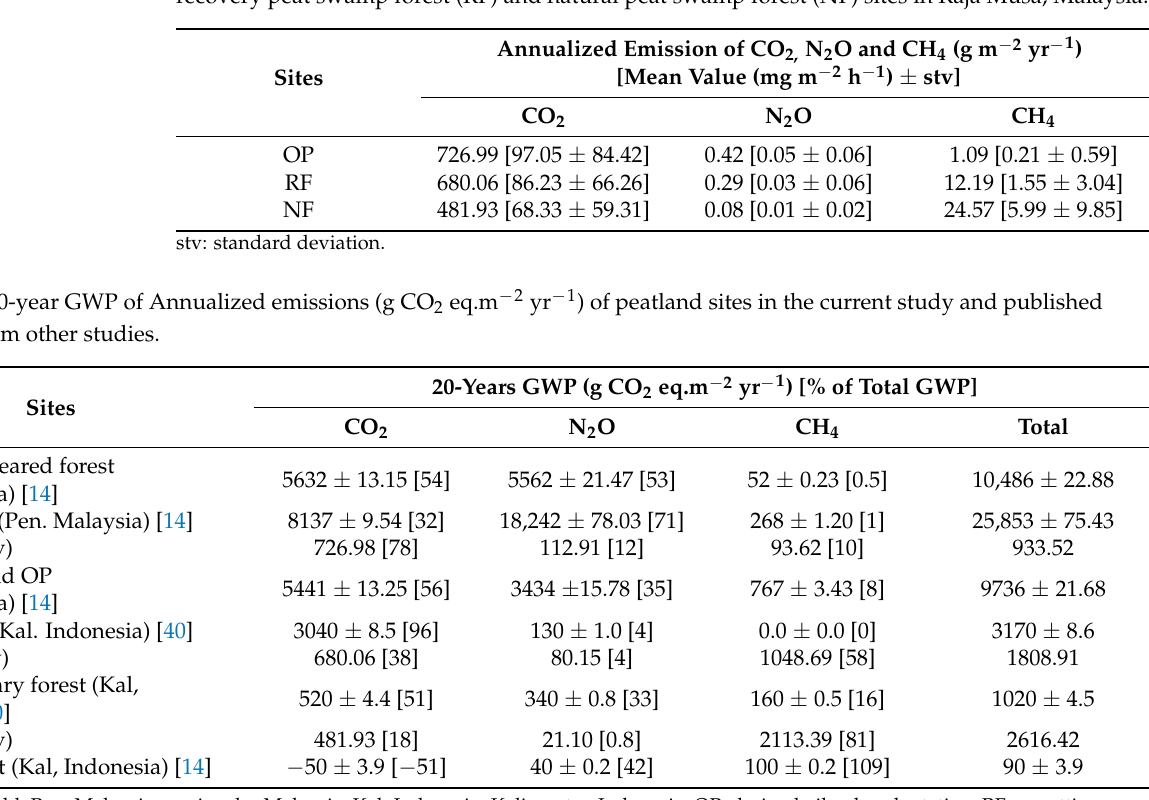
Table 2. Annualized emission of CO 2, N 2 O and CH 4 (g m − 2 yr − 1 ) at the oil palm plantation (OP),